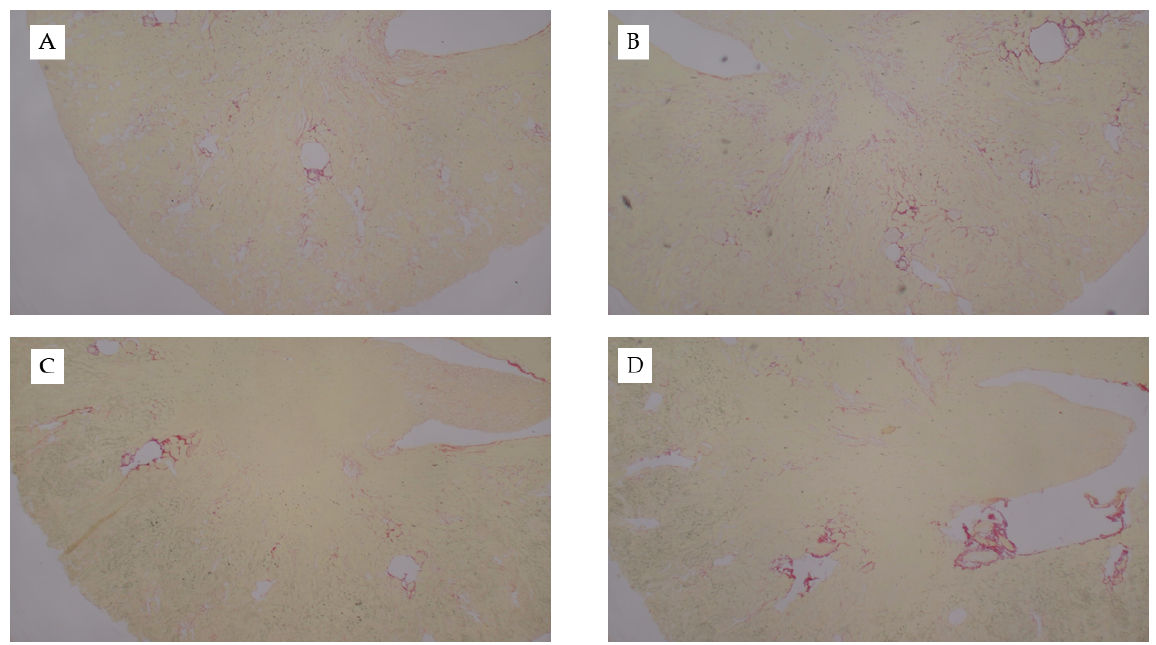
Figure A2. Picro Sirius-stained kidney sections from uIRI study. Representative images of Picro Sirius-stained kidney tissue